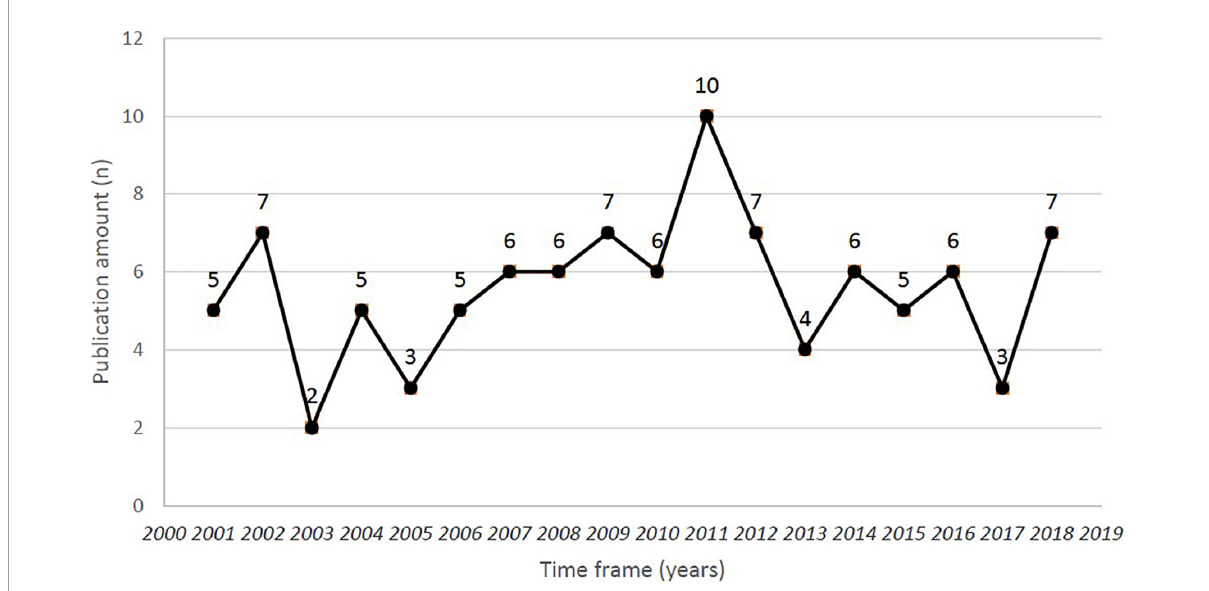
FIGURE1 Time frame and publication amount for the top 100 most-cited studies of pemphigoid